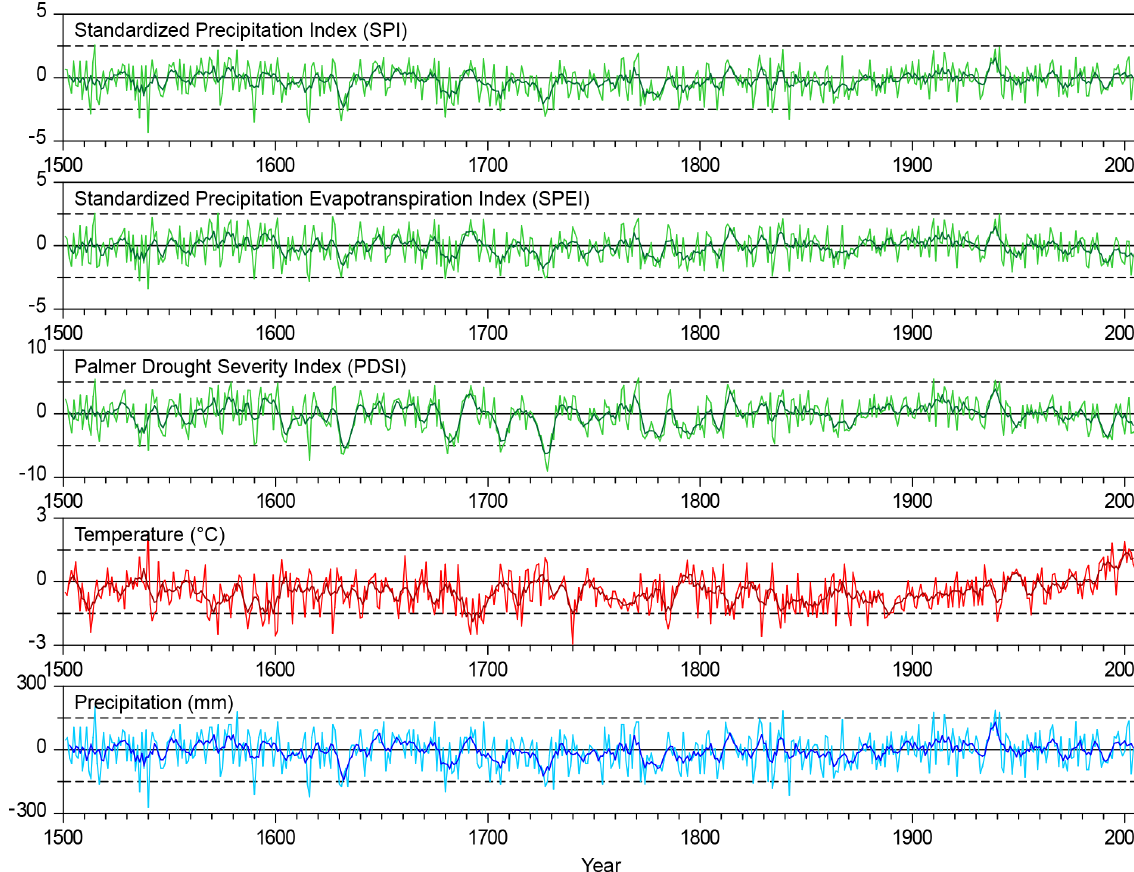
Figure 1. Annual series of drought indices, temperature and precipitation anomalies (with respect to 1961–1990 reference period) for the Czech Lands in the 1501–2006 period, also smoothed by 11-year running means (darker